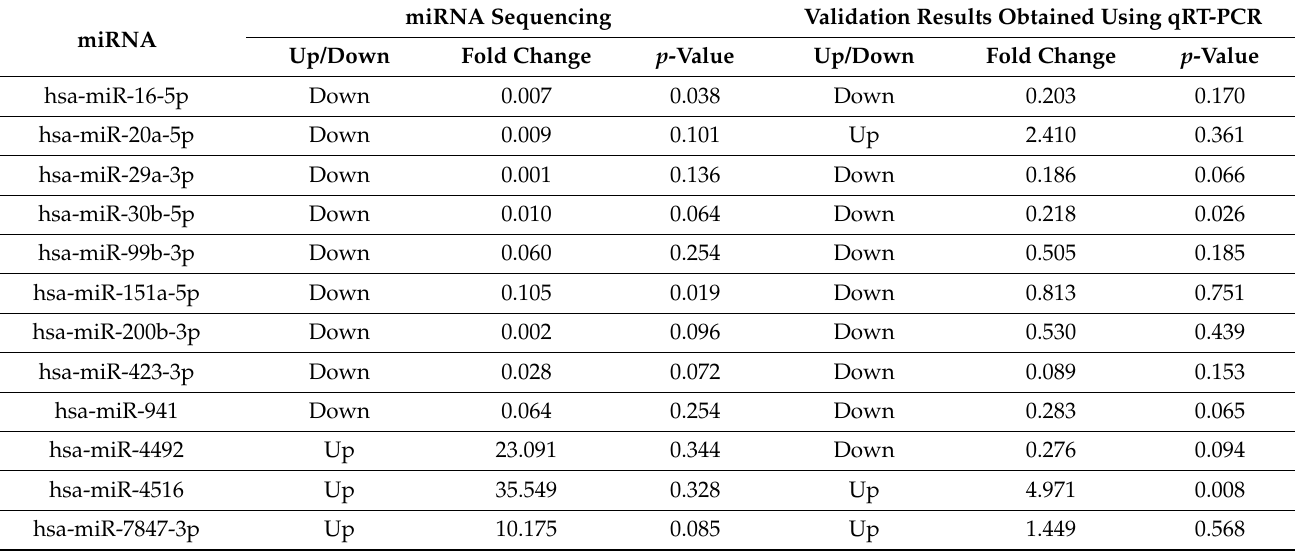
Table 6. Comparison of the relative expression patterns of selected microRNAs in patients with premature ovarian insufficiency. miRNA